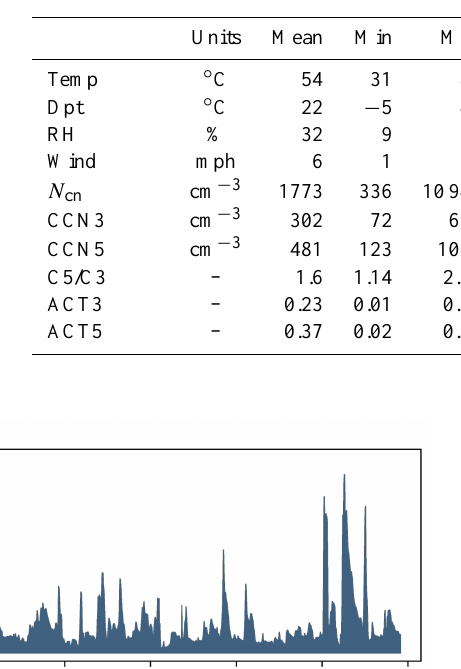
Table 1. Statistical information for physical quantities observed at MVNP. These represent the entire time series from 9/22-10/16. Lag quantities are autocorrelations for lags of 1, 10 and 24h. The effective sample size, n 0 , is computed using Eq. (1). Labels are as follows: CCN3 = N ccn (SS = 0.3%); CCN5 = N ccn (SS = 0.5%); ACT3 = N ccn (SS = 0.3%)/ N cn ; ACT5 = N ccn (SS = 0.5%)/ N cn ; and C5/C3 = N ccn (SS = 0.5%)/ N ccn (SS = 0.3%).